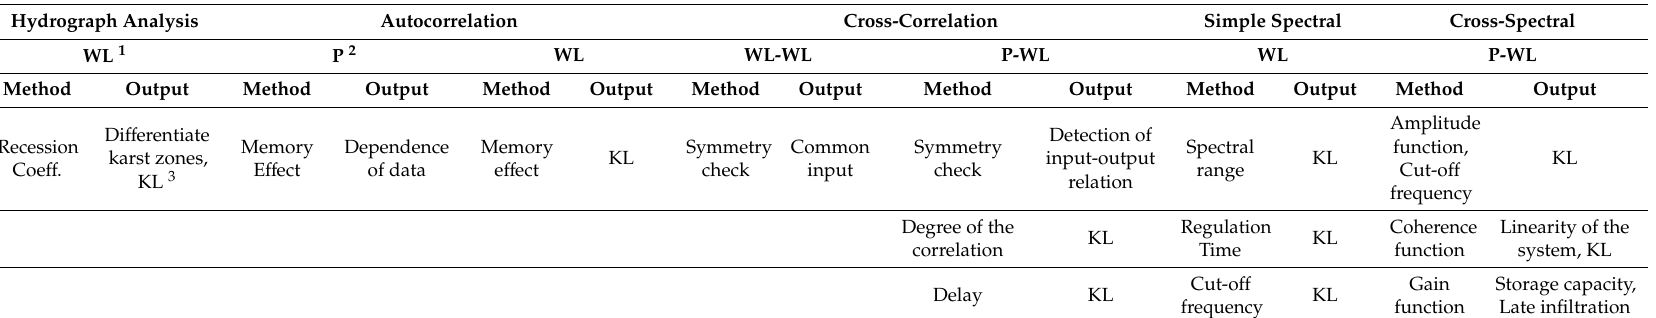
Table 3. Approaches, data, methods and the expected